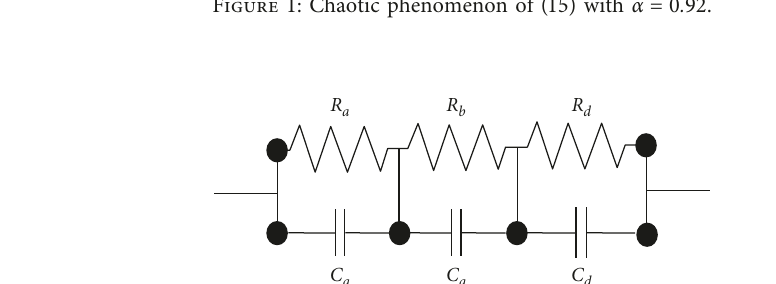
Figure 1: Chaotic phenomenon of (15) with α � 0 . 92.